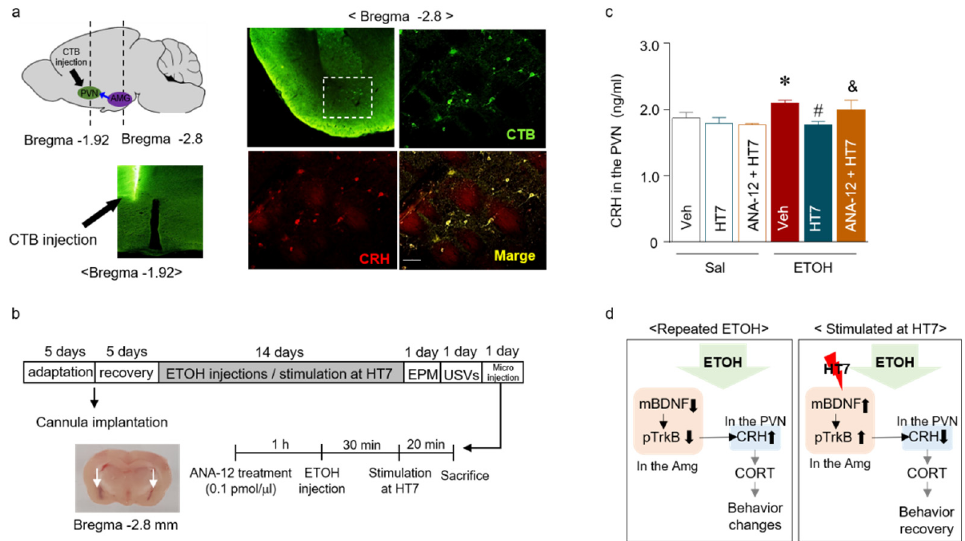
Figure 7. Schematic showing the microinjection protocol and needle placement in the PVN (left panel). CRH-immunoreactive neurons (magenta) and the infusion site of Alexa Fluor 488-conjugated cholera toxin subunit B (CTB-488, green) in the amygdala are shown (right panel). The scale bar represents 100 μ m ( a ). Schematic showing the schedule of acupuncture stimulation and microinjection into the amygdala ( b ). CRH levels in the amygdala after pretreatment with the TrkB antagonist (ANA-12, 0.1 pmol/ μ L) before stimulation of the Shenmen point (acupuncture point heart 7: HT7) (n = 6–8 rats per group) ( c ). The proposed mechanism underlying the relationship between BDNF and CRH and the effect of acupuncture stimulation ( d ). The data were analyzed using repeated measures ANOVA followed by Tukey’s test. * p < 0.05 compared with the Sal group, # p < 0.05 compared with the ETOH group, and & p < 0.05 compared with the ETOH + HT7 group. Values are presented as means ± SEM.